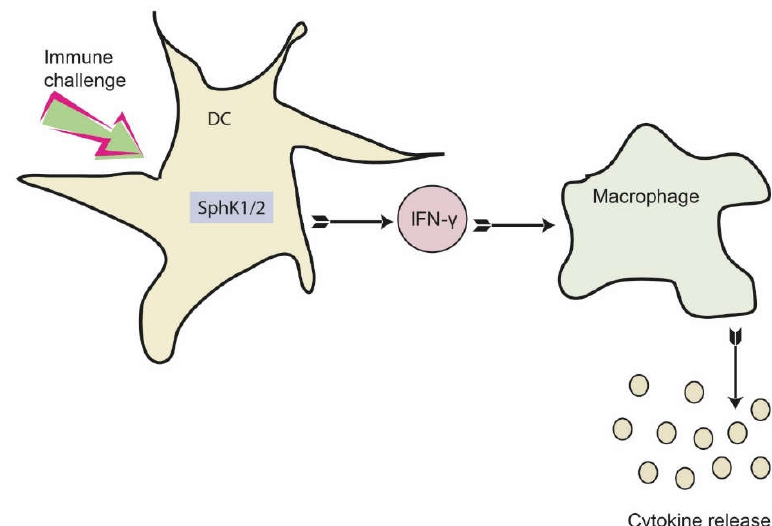
Figure 7. Proposed role of SphKs in DC for dampening the early cytokine response after systemic infection. Activation of SphK1/2 in DC results in increased IFN-γ release, which consequently activates macrophages. As a result, macrophages produce and secrete a number of additional pro-inflammatory cytokines. This eventually results in a dysregulated immune response, which may be prevented by inhibition of SphK1/2 in DC.